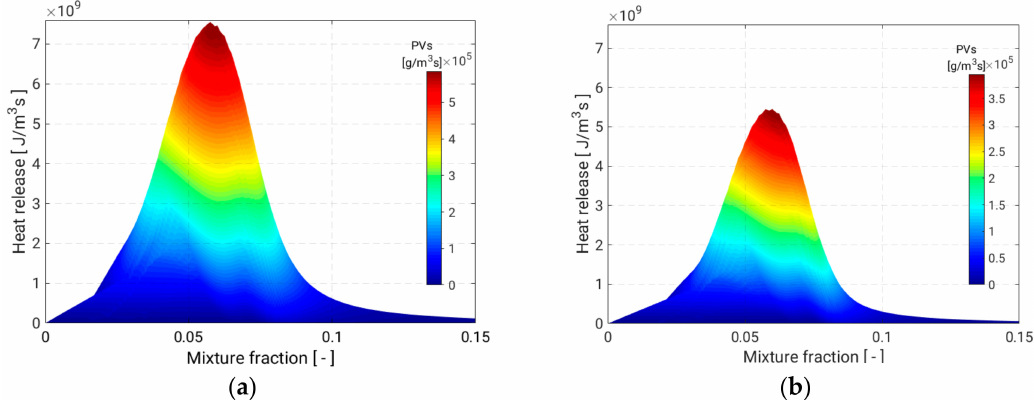
Figure 1. Production rate of heat release in the mixture fraction space coloured with source term of the PV. ( a ) distribution of heat release in Flames A1, B3 tables, ( b ) distribution of heat release in Flame A3